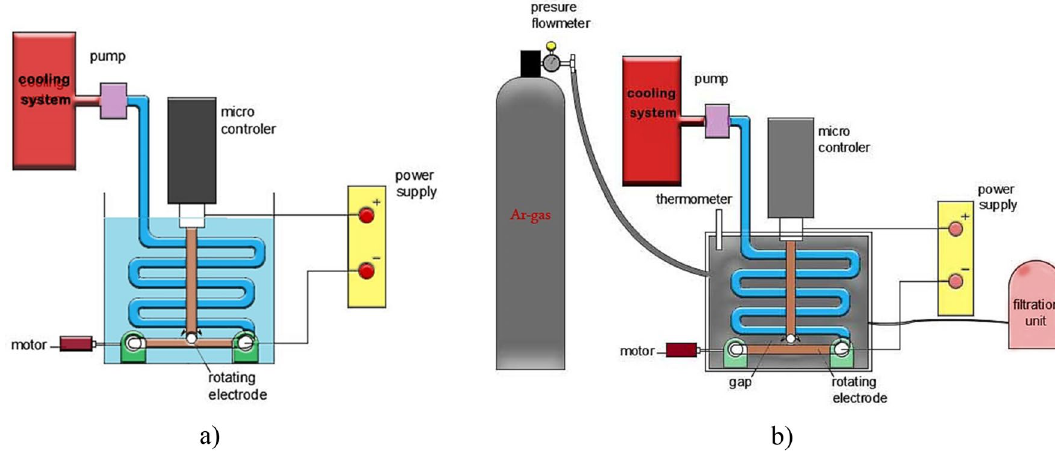
Figure 1. Arc-discharge machine unit using ( a ) deionized water ( b ) Ar